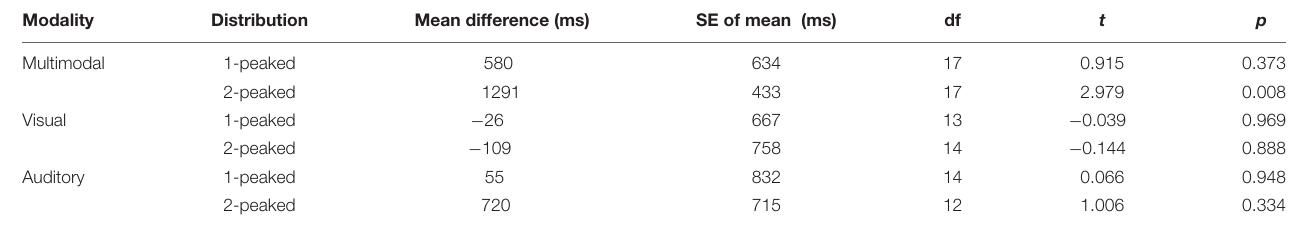
TABLE 2 | Difference scores and their significance against zero for each